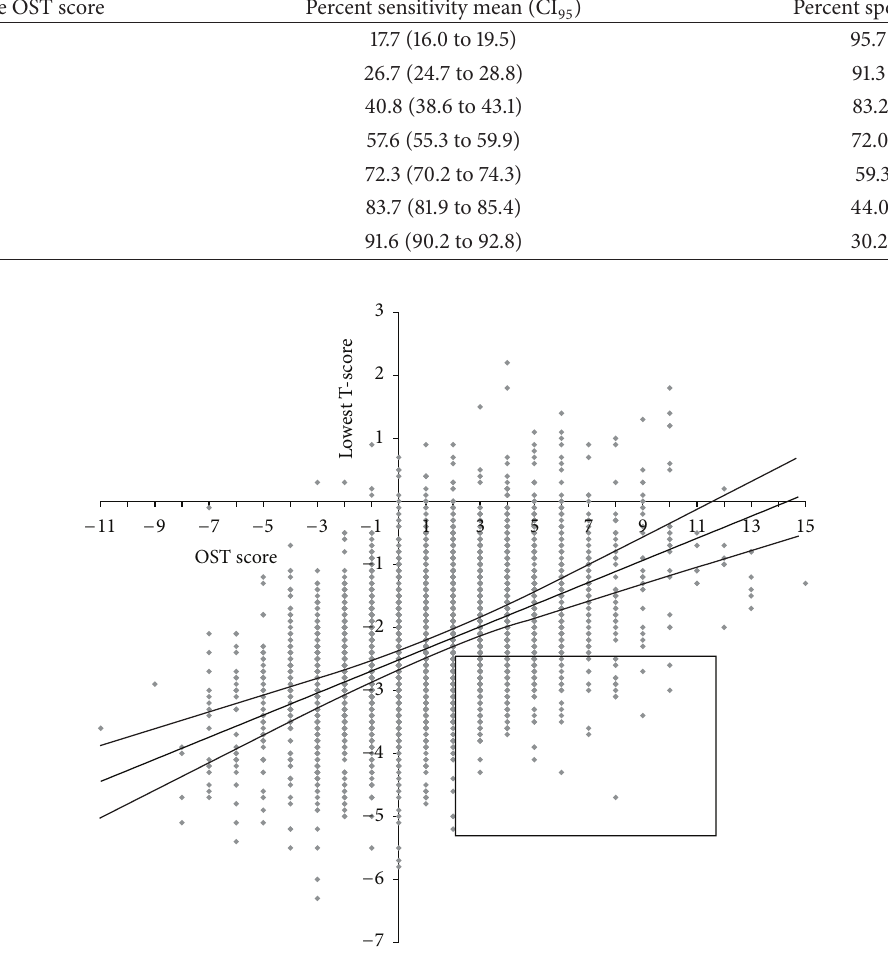
Table 3: Sensitivity and specificity of the OST score for predicting a T-score of − 2.5 or below at any site, according to the cut-off value. Cut-off value of the OST score